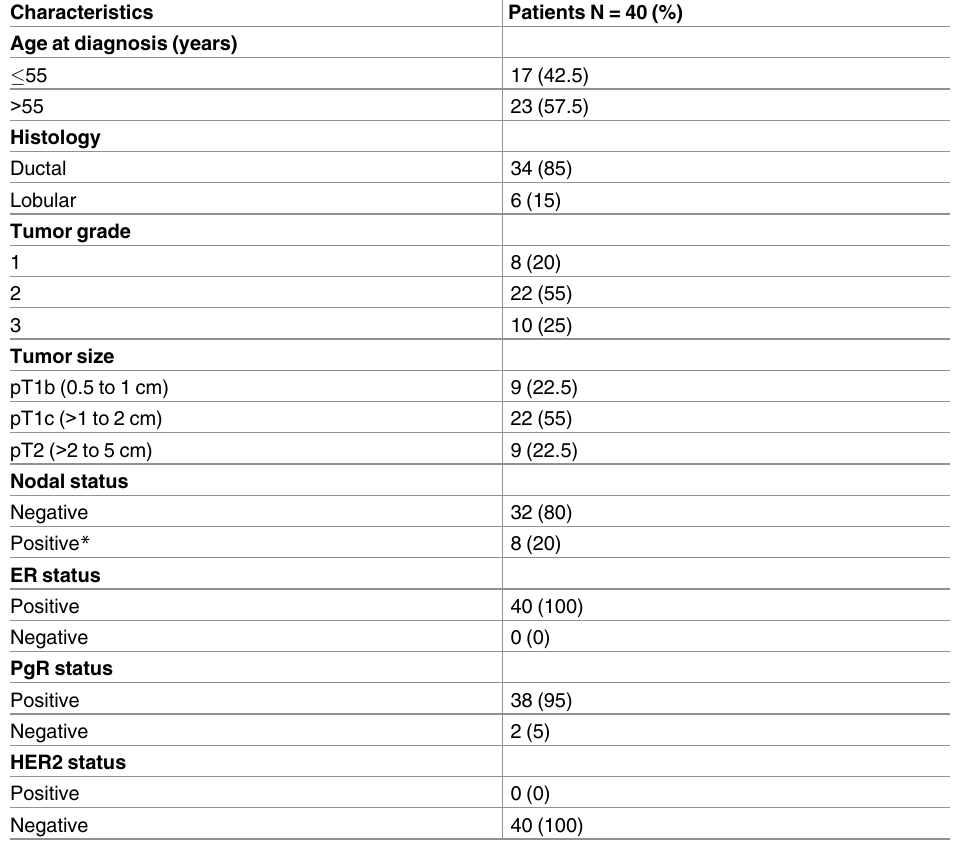
Table 1. Characteristics of the 40 patients included in the